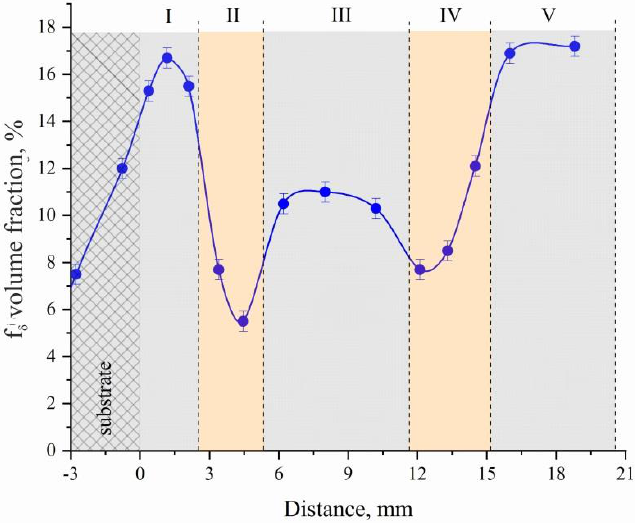
Figure 9. Dependence of δ-Fe volume fraction on distance of substrate using a local type ferritom- eter.